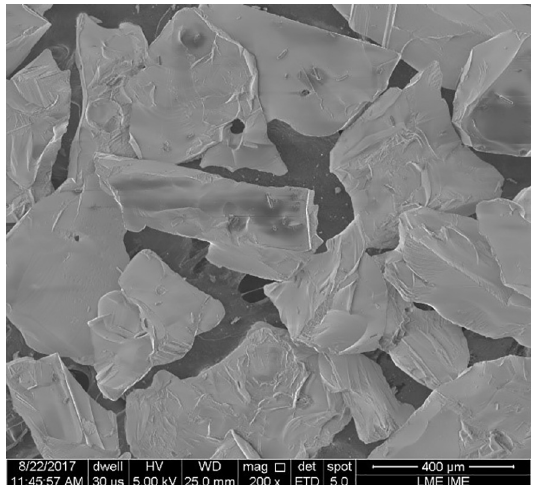
Figure 6. SEM image of the alumina powder.